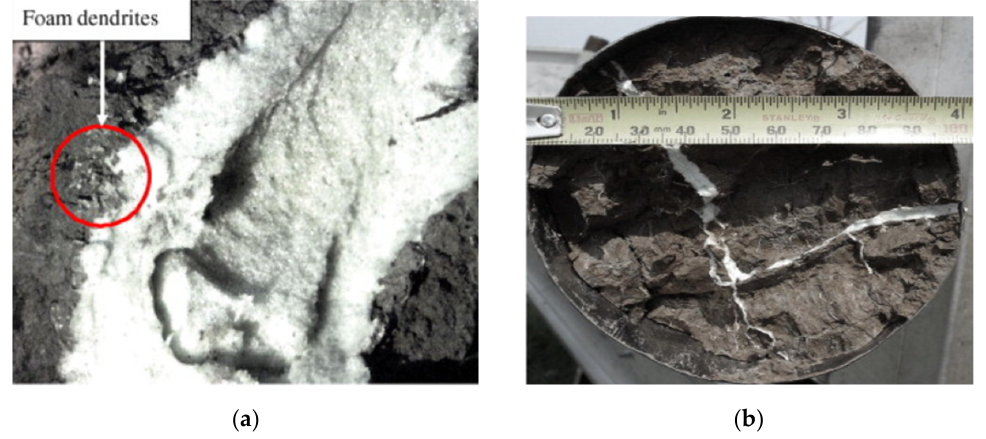
Figure 3. ( a ) View of foam formed in the ground; ( b ) view of foam injected soil specimen. Reproduced from [43], with permission from Elsevier, 2008.